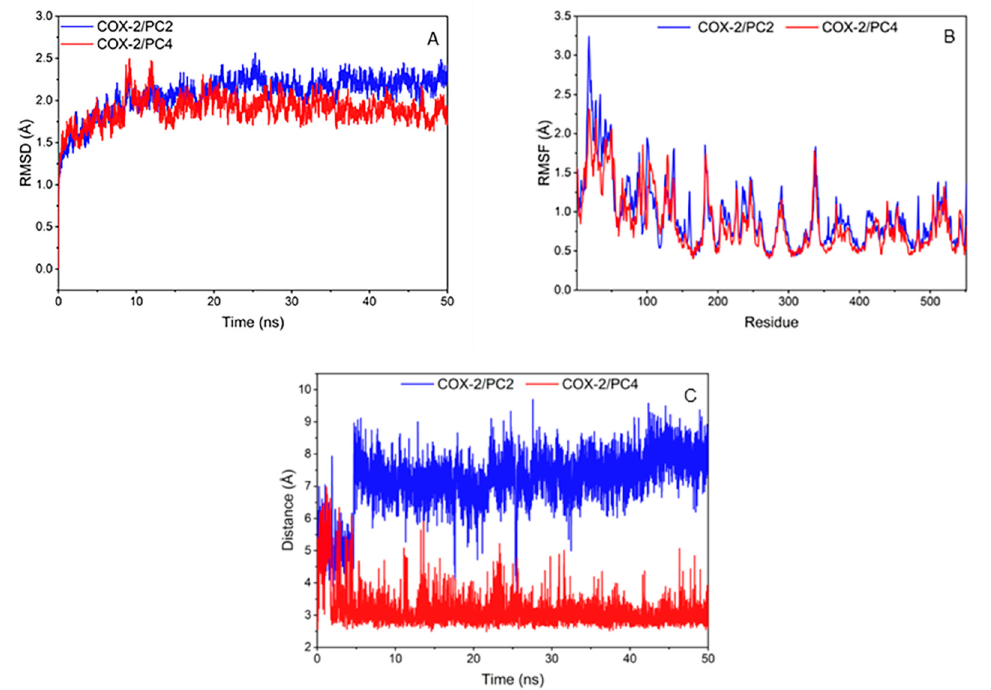
Figure 4. ( A ) Root mean square deviation (RMSD) between amino acid skeleton atoms from cyclooxygenase-2 (COX-2) during simulation; ( B ) Hydrophobic binding diagram of ligand-protein complex and fluctuation of root mean square fluctuation value (RMSF) of amino acid skeleton atoms; ( C ) Distance plot of atom pairs involved in the formation of hydrogen bonds between 7 ´ oxygen atom of hydroxy-2,4,7-trimethoxyphenanthrene (PC2)/6,7-dihydroxy-2,4-dim ethoxy-phenanthrene (PC4) and hydroxyl of Tyr385 in the course of molecular dynamics simulation trajectory.